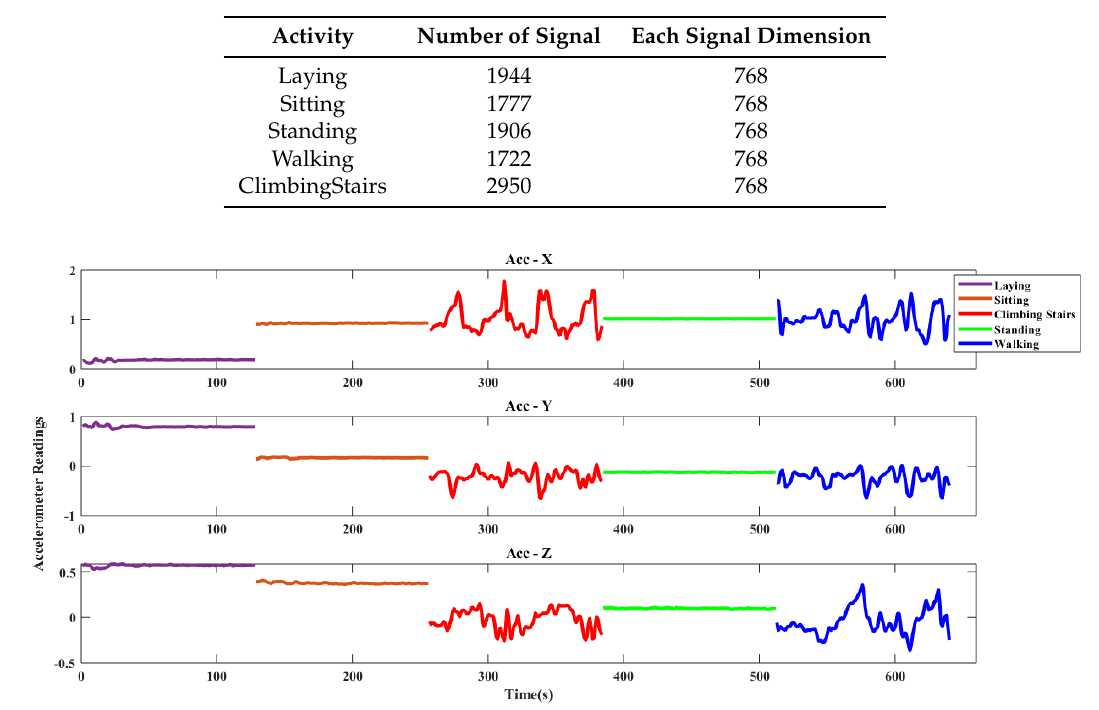
Figure 5. Triaxial accelerometer data of UCI-HAR dataset.